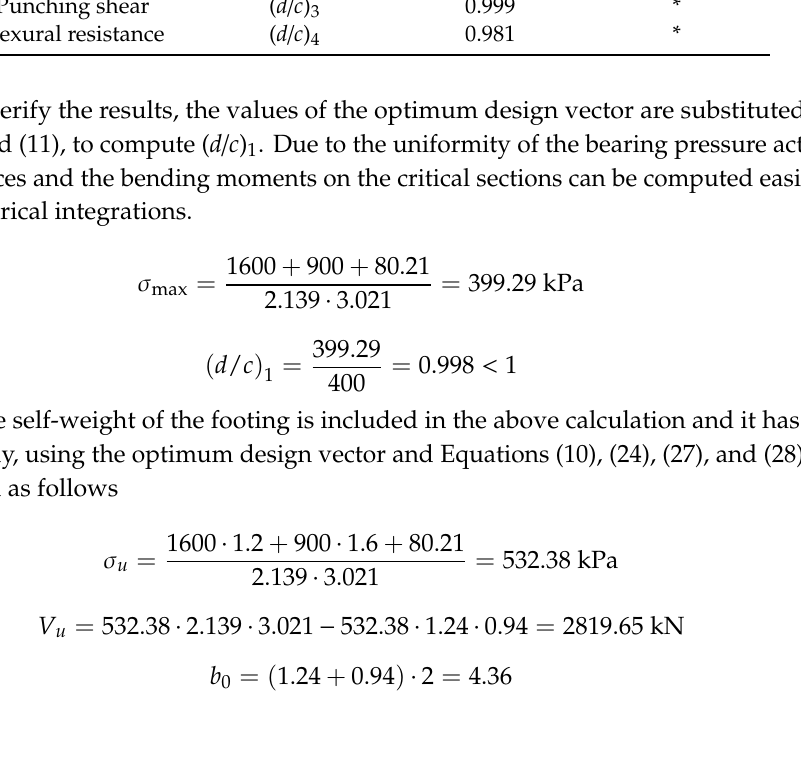
Table 9. Example 2: Demand–capacity ratios corresponding to the optimum design vector.